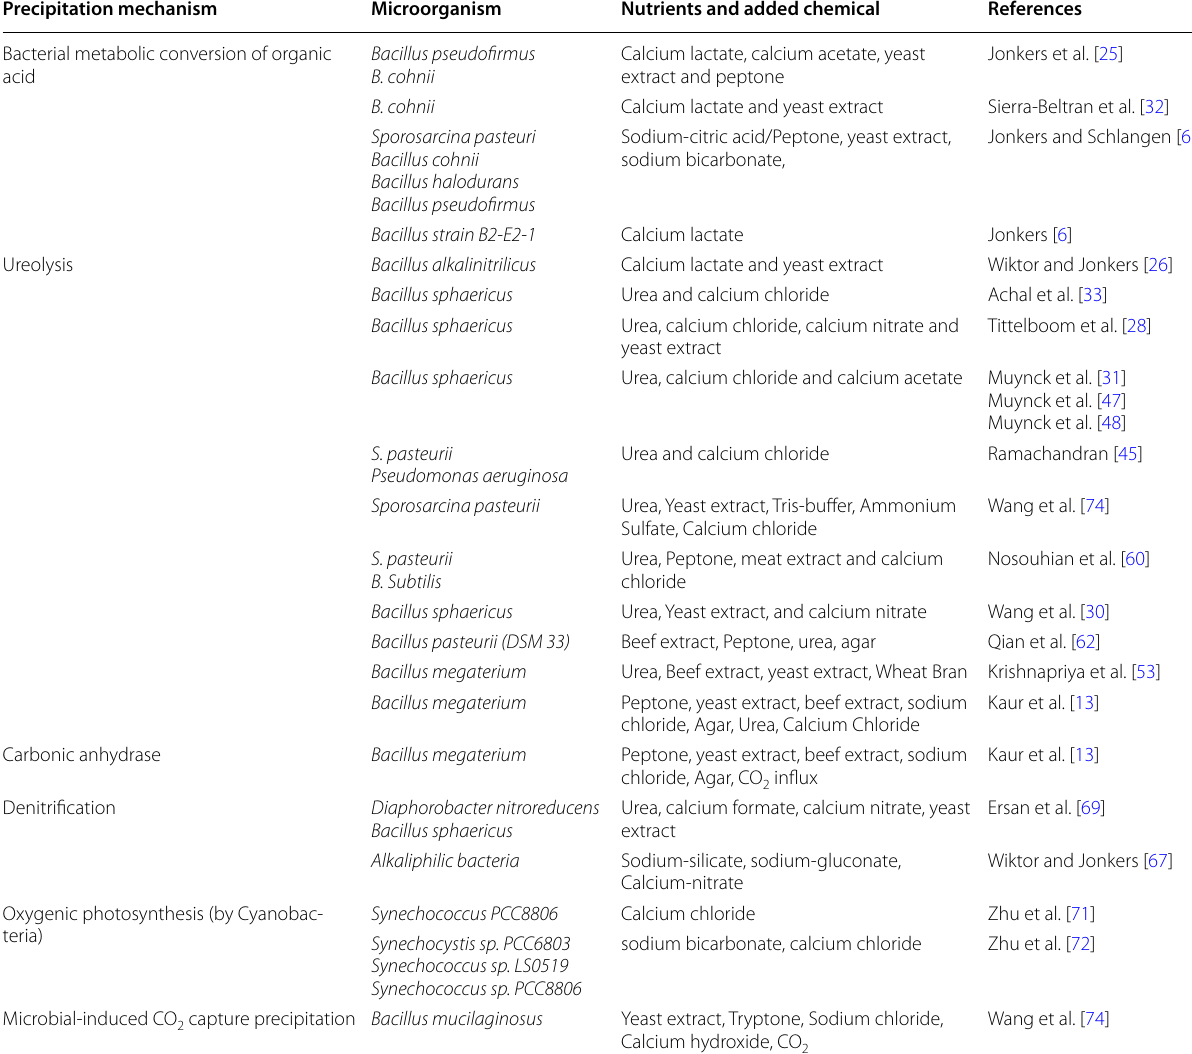
in concrete/mortar matrix 3